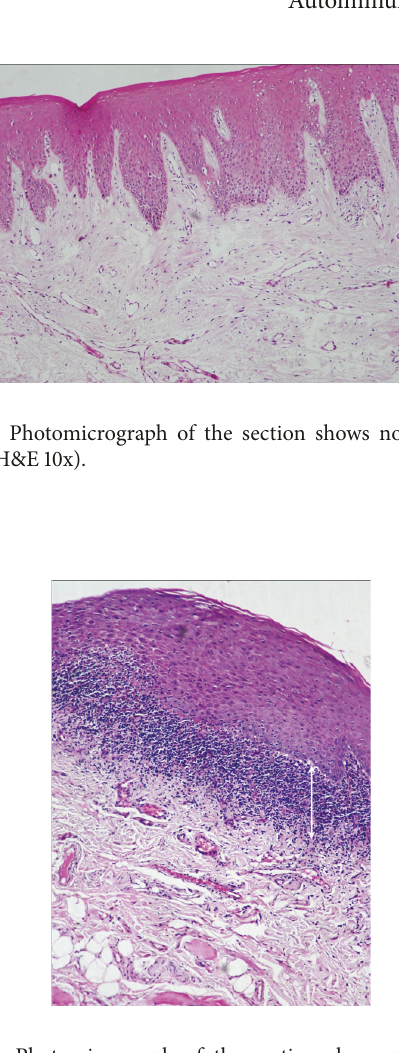
Figure 2: Photomicrograph of the section shows parakeratotic stratified squamous epithelium with juxtaepithelial band of inflam- matory infiltration in oral lichen planus (H&E 10x). The arrows refer to juxtaepithelial band of inflammatory infiltration in oral lichen planus.